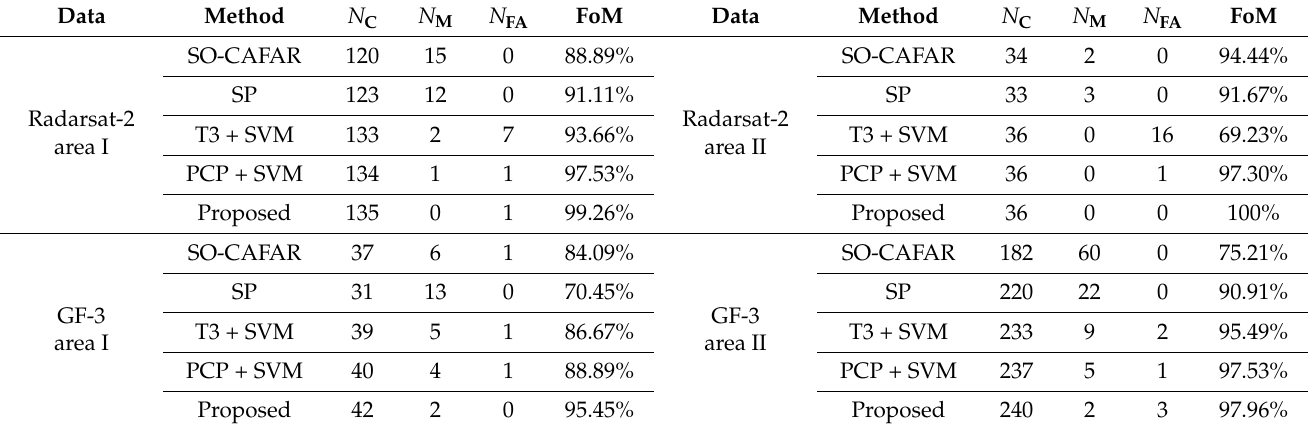
Table 2. Quantitative results comparison with GF-3 area I training